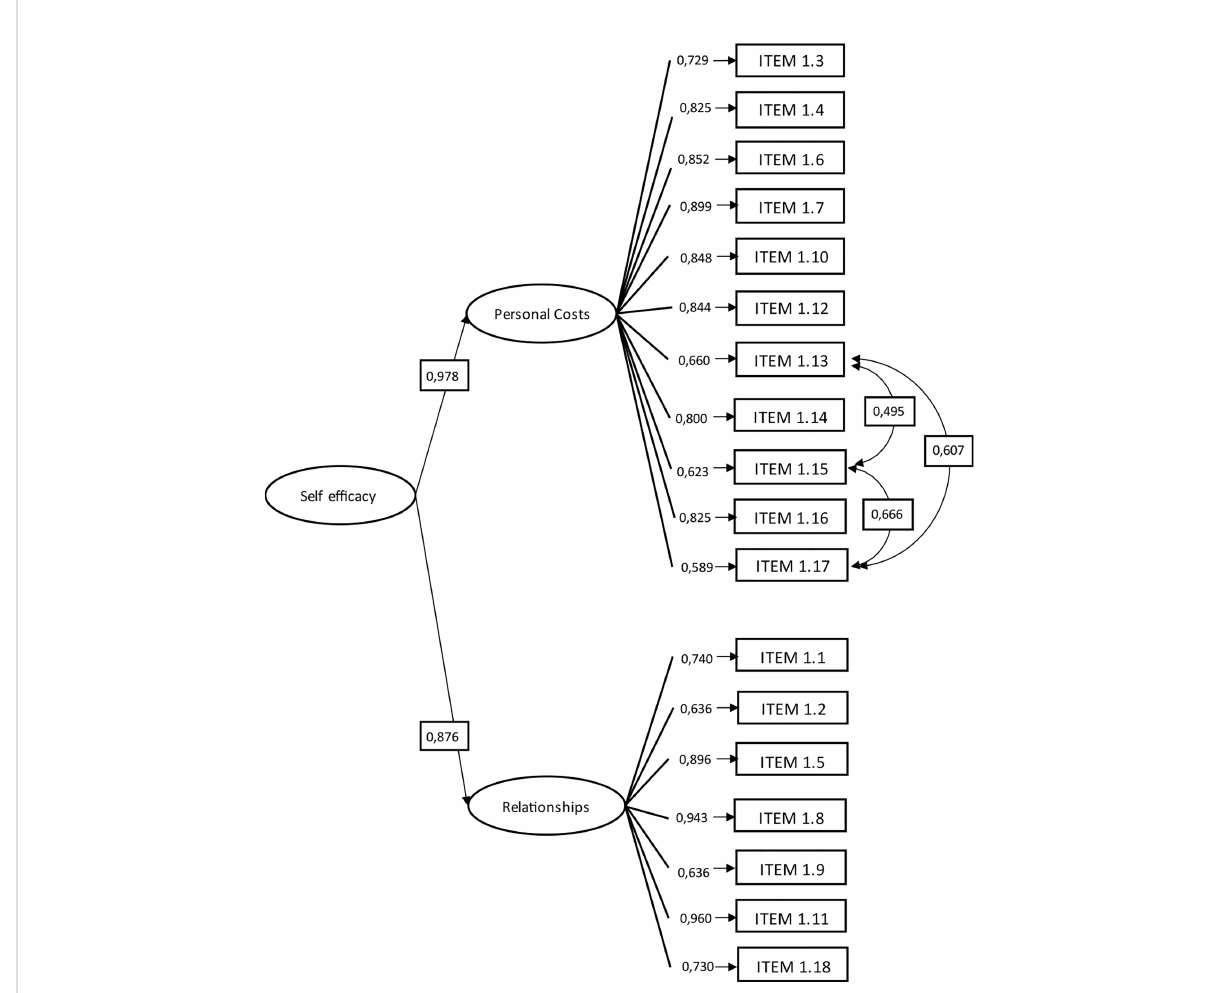
FIGURE 1 Factor loadings of fi rst and second-order and correlations between items of the fi nal model (n =